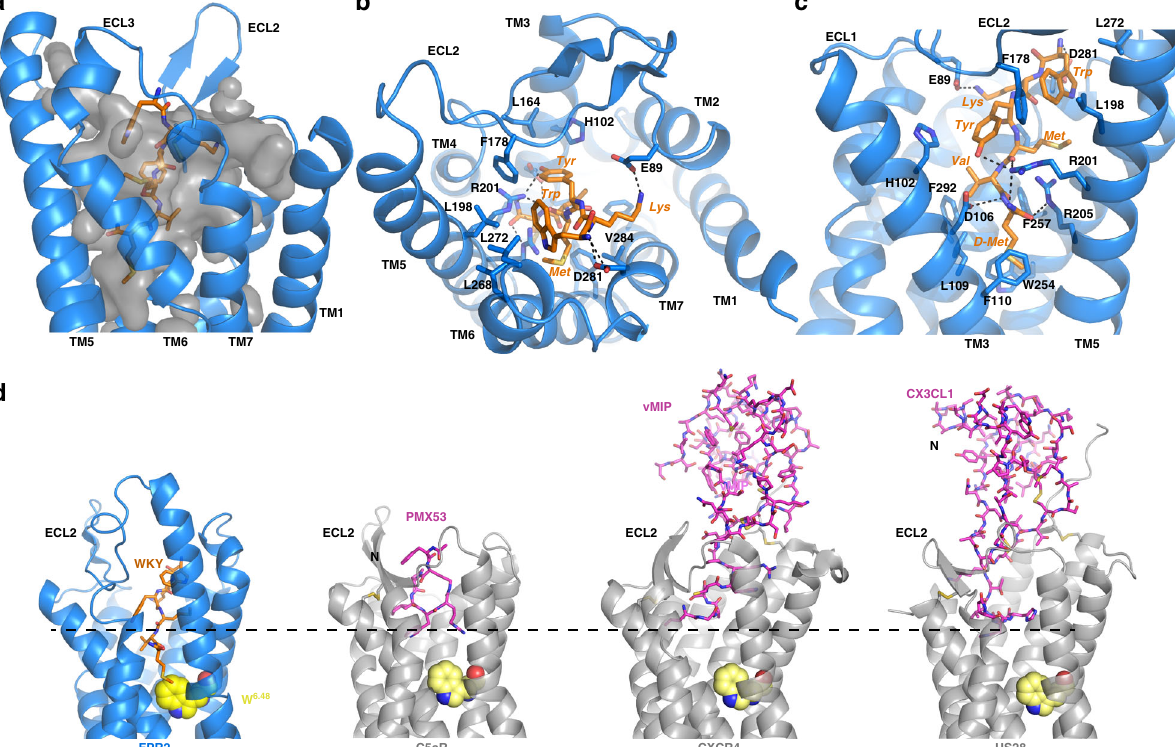
Fig. 2 Binding pocket for WKYMVm. a The overall shape of binding pocket for WKYMVm is shown in gray. b Binding pose of WKYMVm viewed from the extracellular surface. c Binding pose of WKYMVm viewed from the side of 7-TM bundle. Residues in FPR2 are labeled with 1-letter names followed by sequence numbers; residues in WKYMVm are labeled with 3-letter names in italics. Polar and hydrogen bonding interactions are shown as black dashed lines. d Structural comparison of chemoattractant GPCRs with peptide ligands. From left to right: FPR2 with agonist WKYMVm (WKY), C5a receptor (C5aR) with antagonist PMX53 (PDB ID 6C1R), chemokine receptor CXCR4 with chemokine antagonist vMIP (PDB ID 4RWS), viral chemokine receptor US28 with chemokine agonist CX3CL1 (PDB ID 4XT1). The conserved W 6.48 residue in each receptor is shown as yellow spheres.